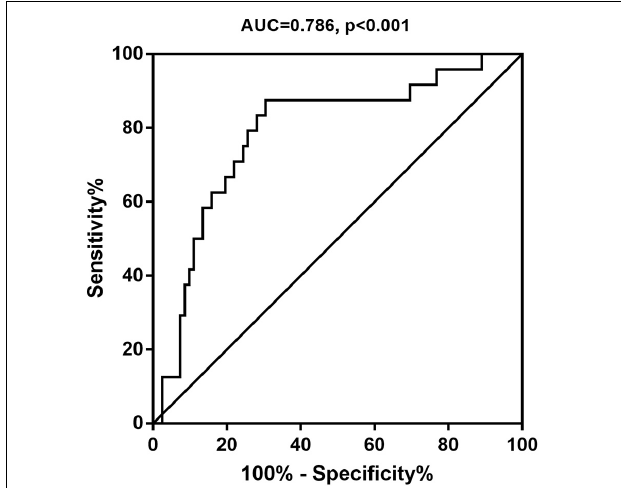
FIGURE 2 | Receiver operating characteristic curve for the 8-oxoGsn/Cre to predict MCI. 8-oxoGsn, 8-oxo-7,8-dihydroguanosine; Cre, creatinine; MCI, mild cognitive impairment; AUC, areas under the